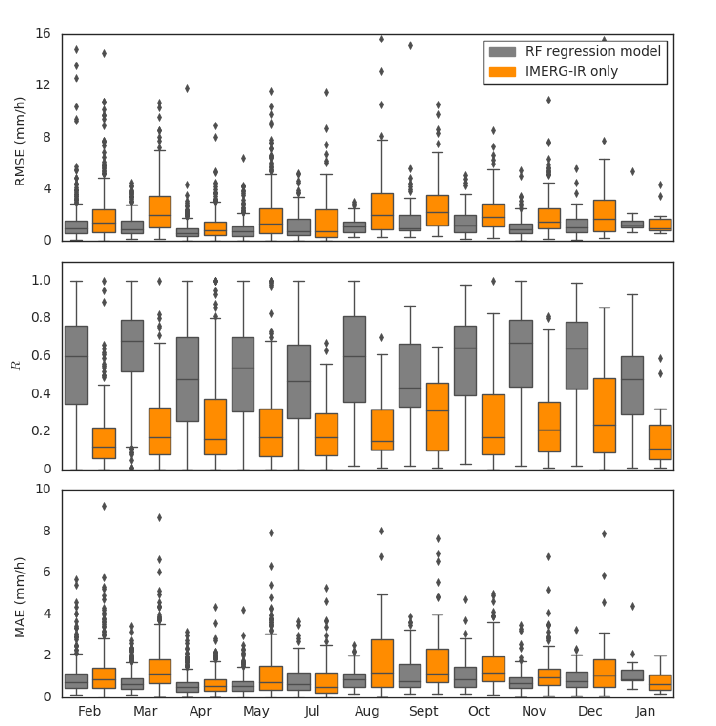
Figure 10. Standard validation scores for RF regression model (rain rate). The scores were calculated on a scene-by-scene basis. Boxes show 25th, 50th, and 75th percentiles. Whiskers extend to the most extreme data point between 75th and 25th percentile. Outliers are shown as